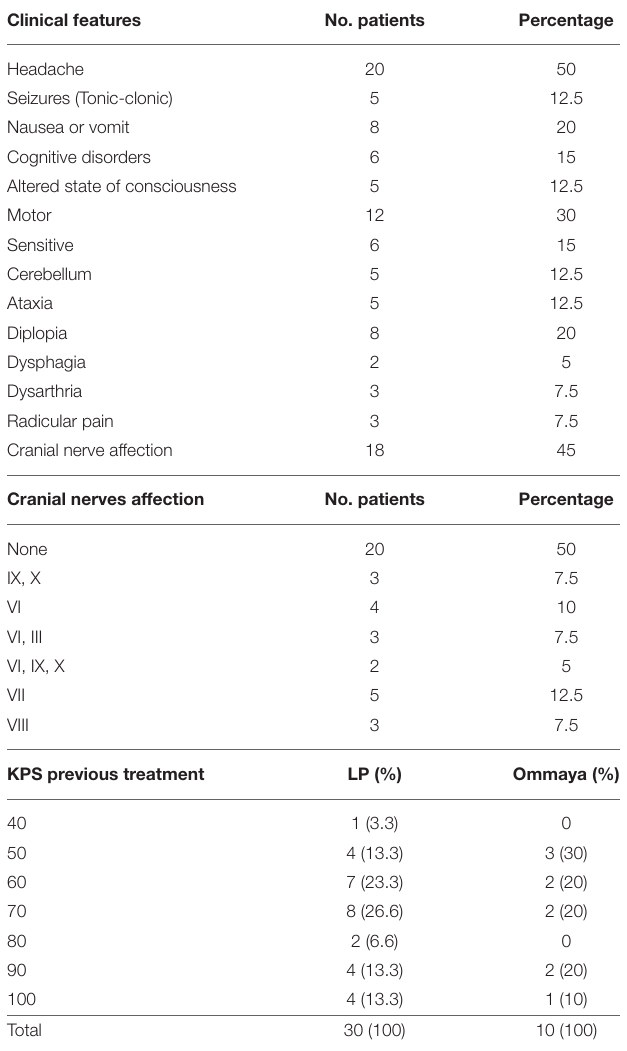
TABLE 2 | Clinical symptoms and cranial nerves affected. Clinical features